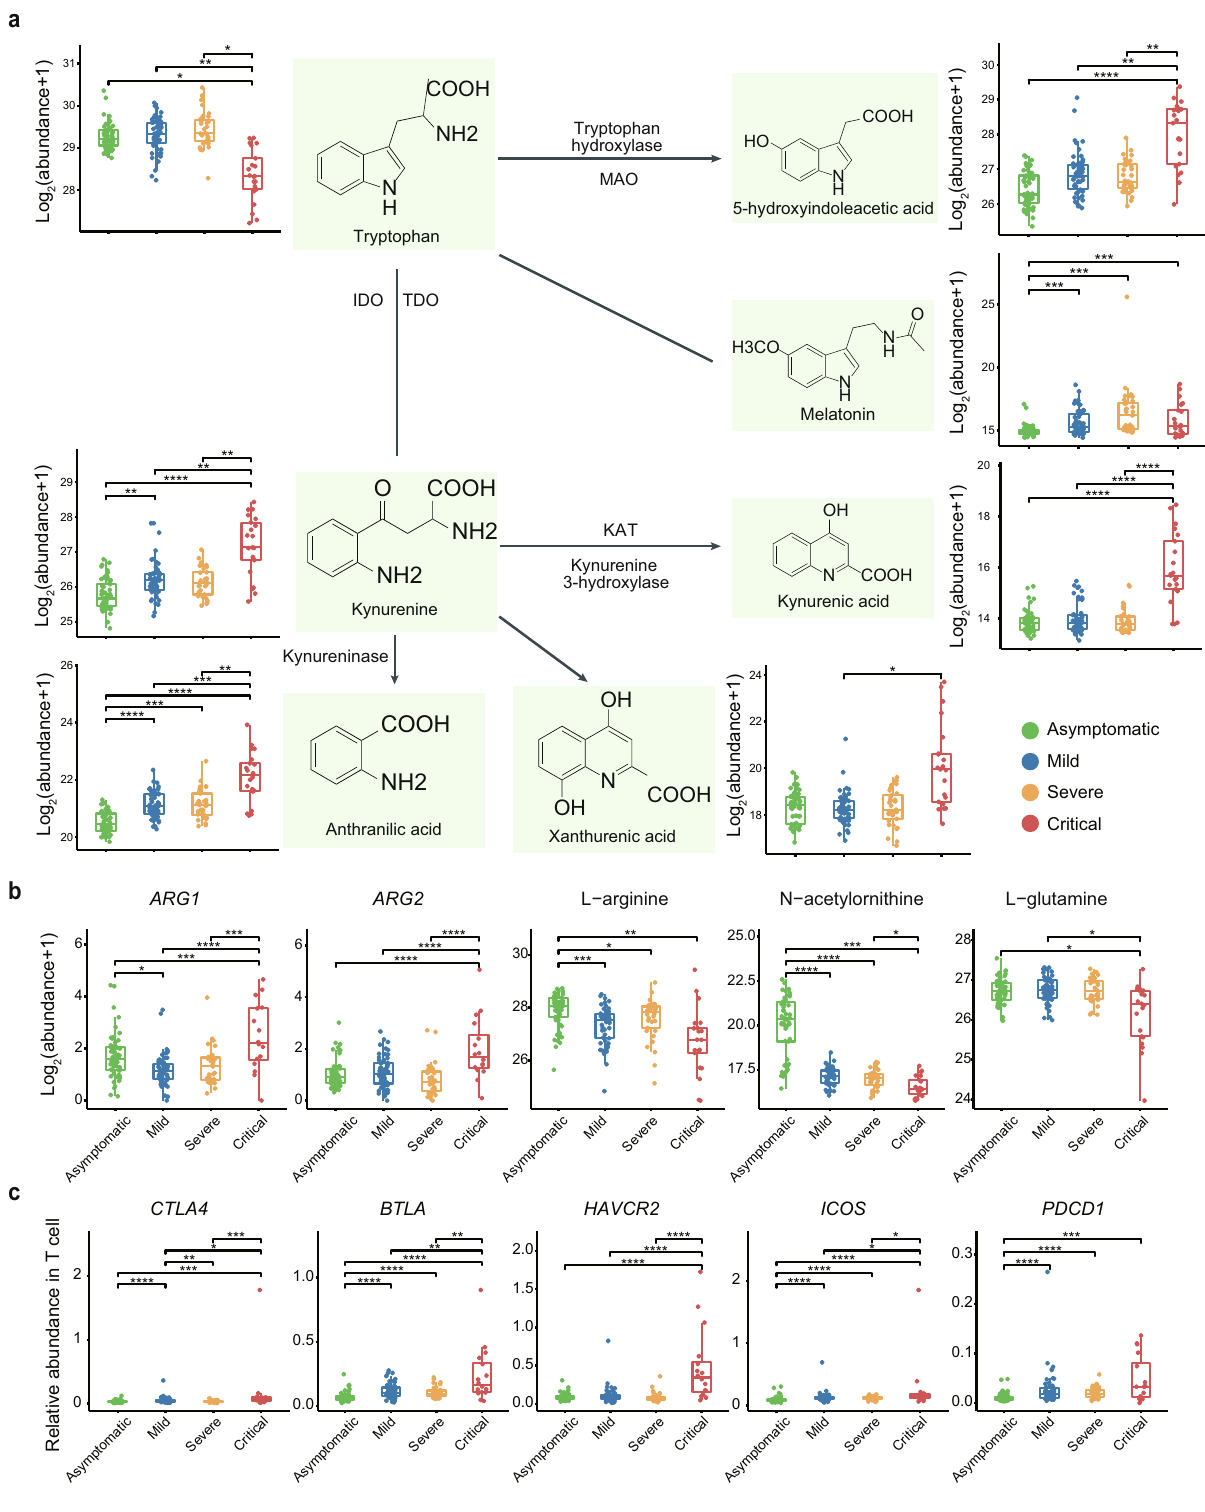
PCR ampli fi cation was performed. (5) Library quality control and pooling 200 – 400 bp. (2) Fragments were end repaired and then 3 ʹ adenylated. Adaptors cyclization were conducted. (6) The RNA library was sequenced using the were ligated to the ends of these 3 ʹ adenylated fragments. (3) PCR and circular- MGI2000 PE100 platform with 100-bp paired-end reads. ization were performed. (4) After library construction and sample quality control, Small RNA data were generated as follows: (1) Small RNA was enriched and whole-genome sequencing was conducted on the MGI2000 PE100 platform with puri fi ed. (2) Adaptor ligation and unique molecular identi fi er (UMI)-labeled 100-bp paired-end reads. primers were added. (3) RT-PCR, library quantitation, and pooling cyclization Transcriptome RNA data were generated as follows: (1) rRNA was removed were performed. (4) Library quality control was conducted. (5) Small RNAs were using the RNase H method. (2) A QAIseq FastSelect RNA Removal Kit was used to sequenced using the BGI500 platform with 50-bp single-end reads, resulting in at remove globin RNA. (3) Puri fi ed fragmented cDNA was combined with End Repair Mix and A-Tailing Mix, then mixed well by pipetting and incubated. (4) least 20M reads for each sample. NATURE COMMUNICATIONS| (2021) 12:4543